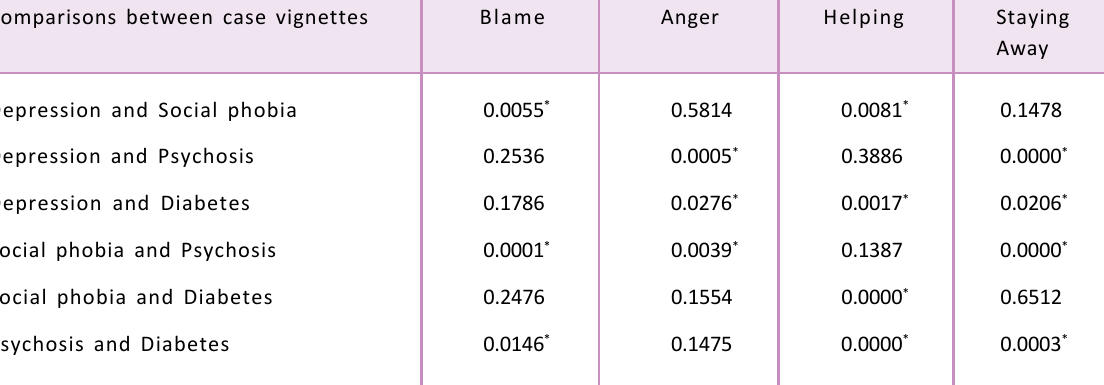
Table 2. Comparison of p-values with regards to the pattern of response, for the selected attributes (blame, anger, helping and staying away), between the four case vignettes Comparisons between case vignettes Blame Helping